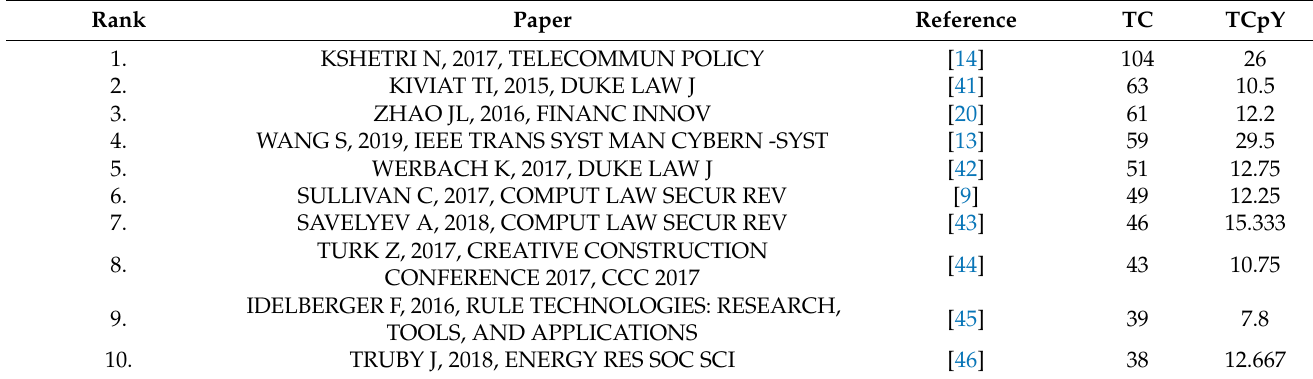
Table 11. Top 10 most global cited documents. Total Citations (TC) and Total Citation per Year (TCpY).